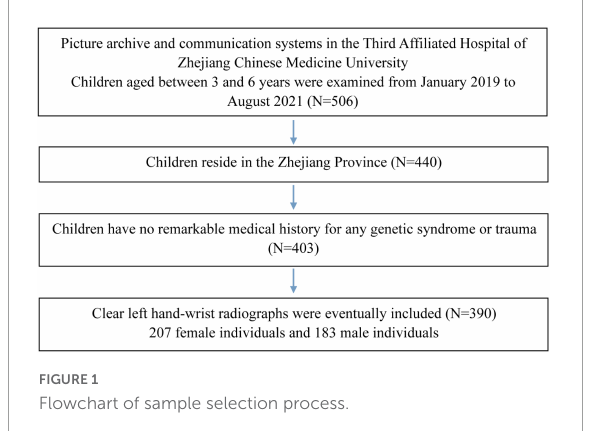
FIGURE1 Flowchart of sample selection